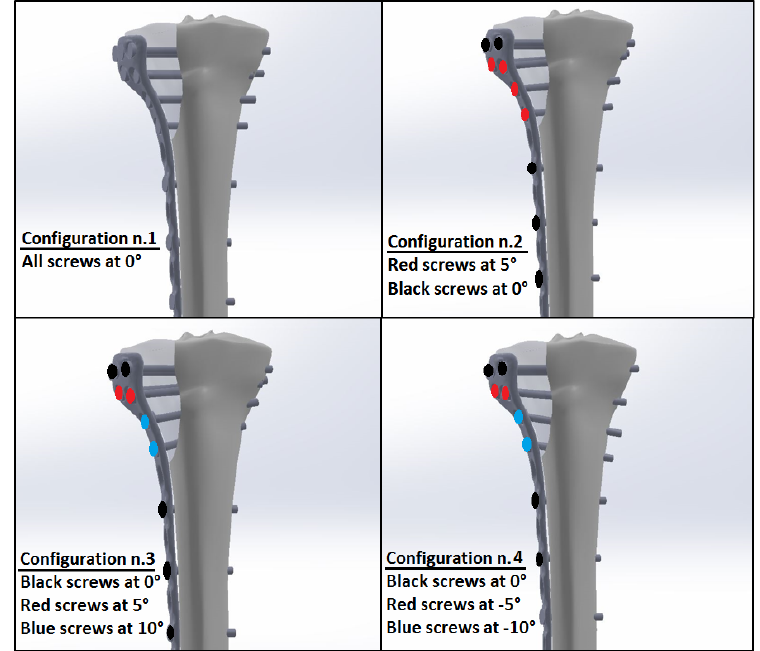
Figure 6. Schemes of the different configurations analysed (the screw angle is measured).